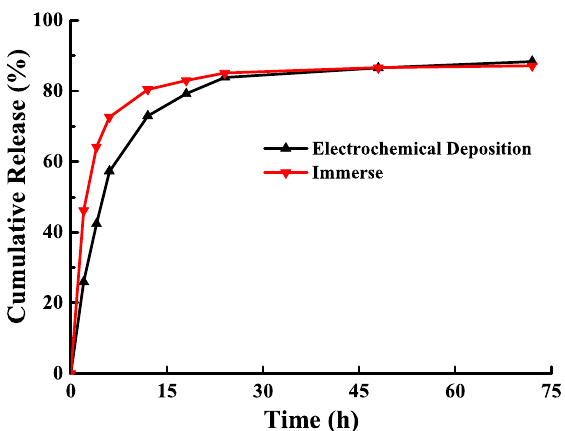
Figure 6. Cumulative release of BMP-2 from the incorporated ECD hybrid coating and immersion samples. Table 1. Drug loading and release rates of BMP-2 from ECD and immersion samples.